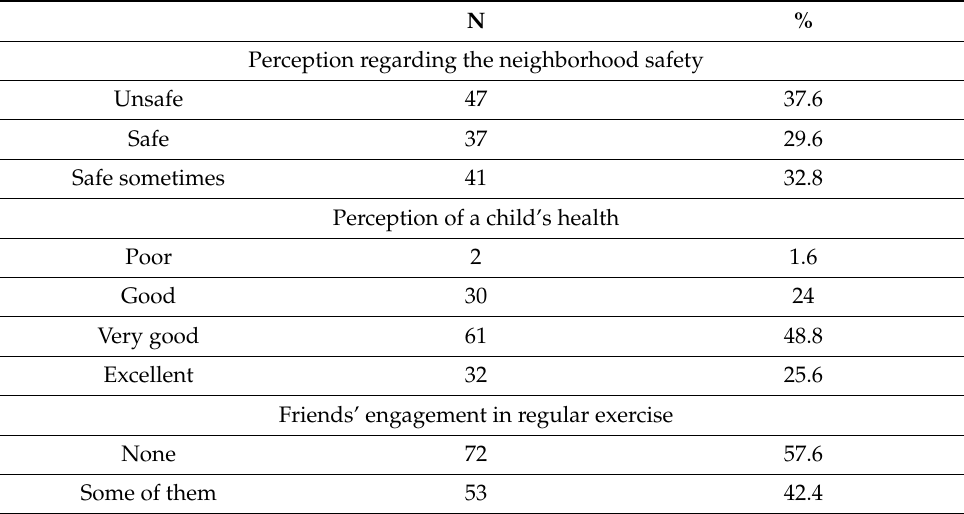
Table 2. Parent’s perception regarding neighborhood safety, child health, and social determinant.